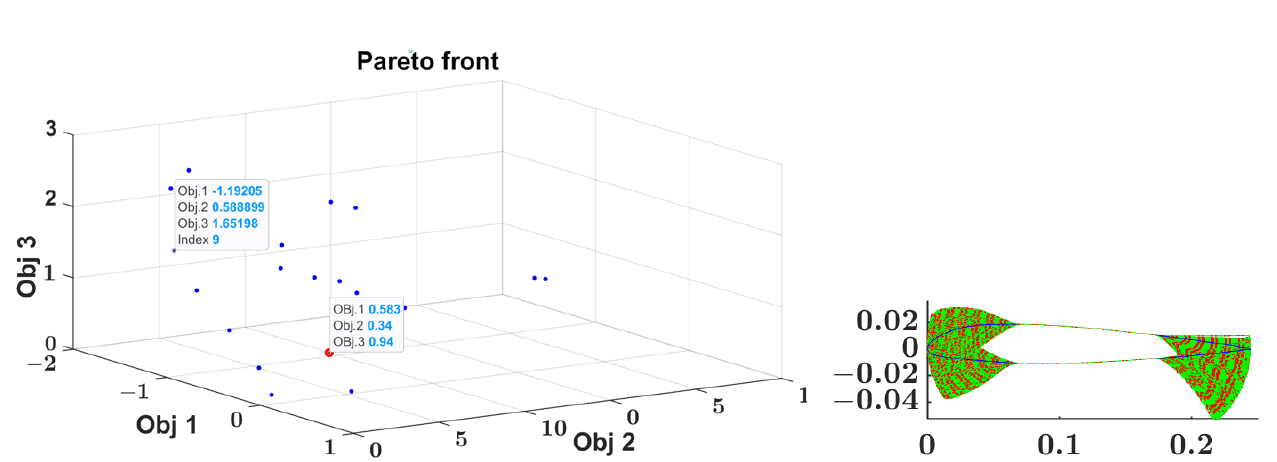
Table 16. Initial and “ global ” morphed NCA 23012. 𝜶 = 4°, Re ∞ = 2.0394 × 10 6